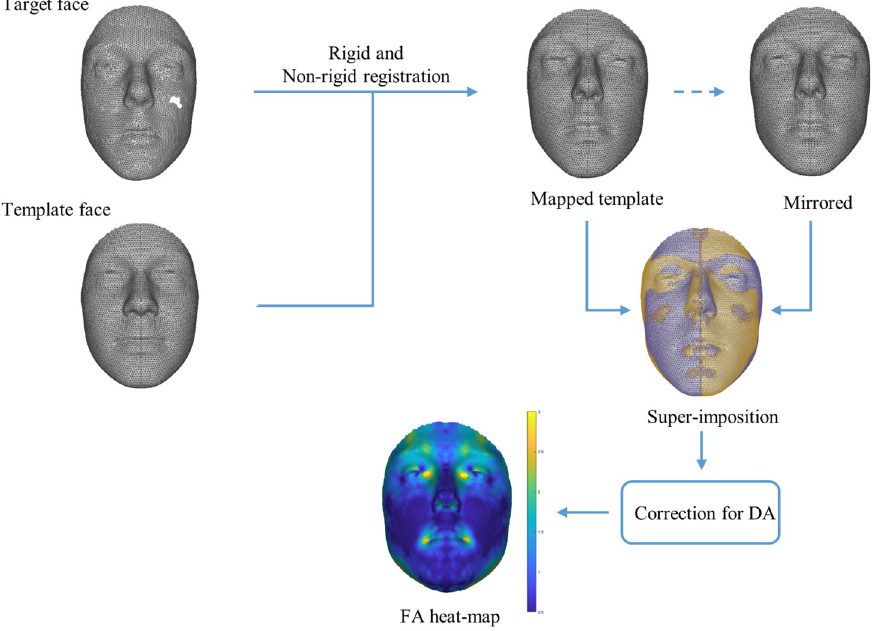
Fig 1. Complete flow diagram of the proposed spatially dense approach for FA